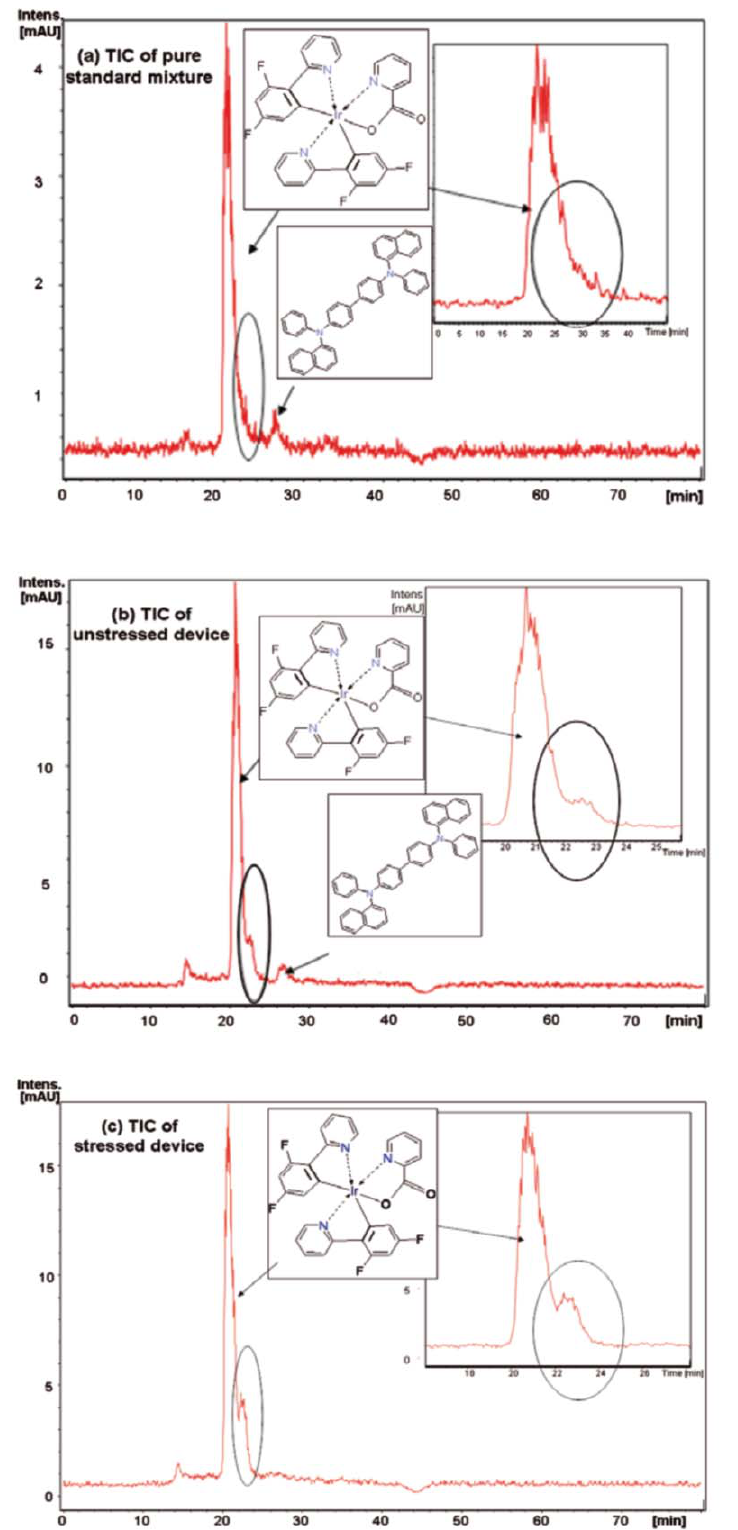
Figure 2. TIC chromatogram of (a) pure materials α -NPD, TCTA, FIrpic and BAlq; (b) unstressed device and (c) stressed